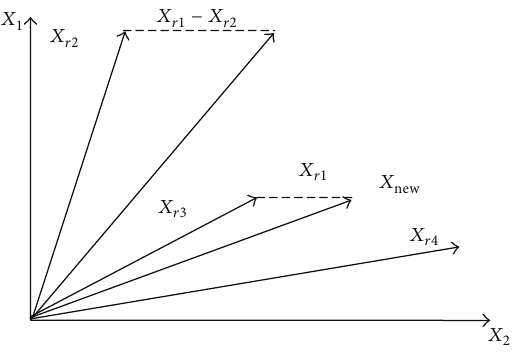
Figure 1: The process of generation new trial solution.